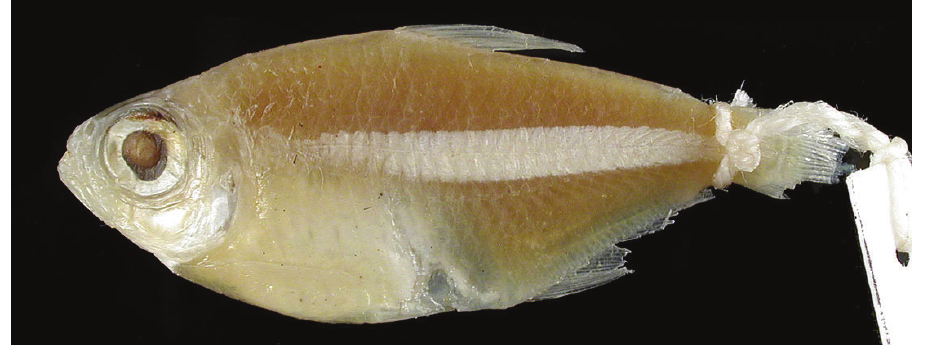
Figure 1. Moenkhausia megalops , holotype, CAS 71433, 40.6 mm SL, Brazil, Pará State, Itaituba, rio Tapajós basin. Figure mod- ified from CAS, all rights reserved.